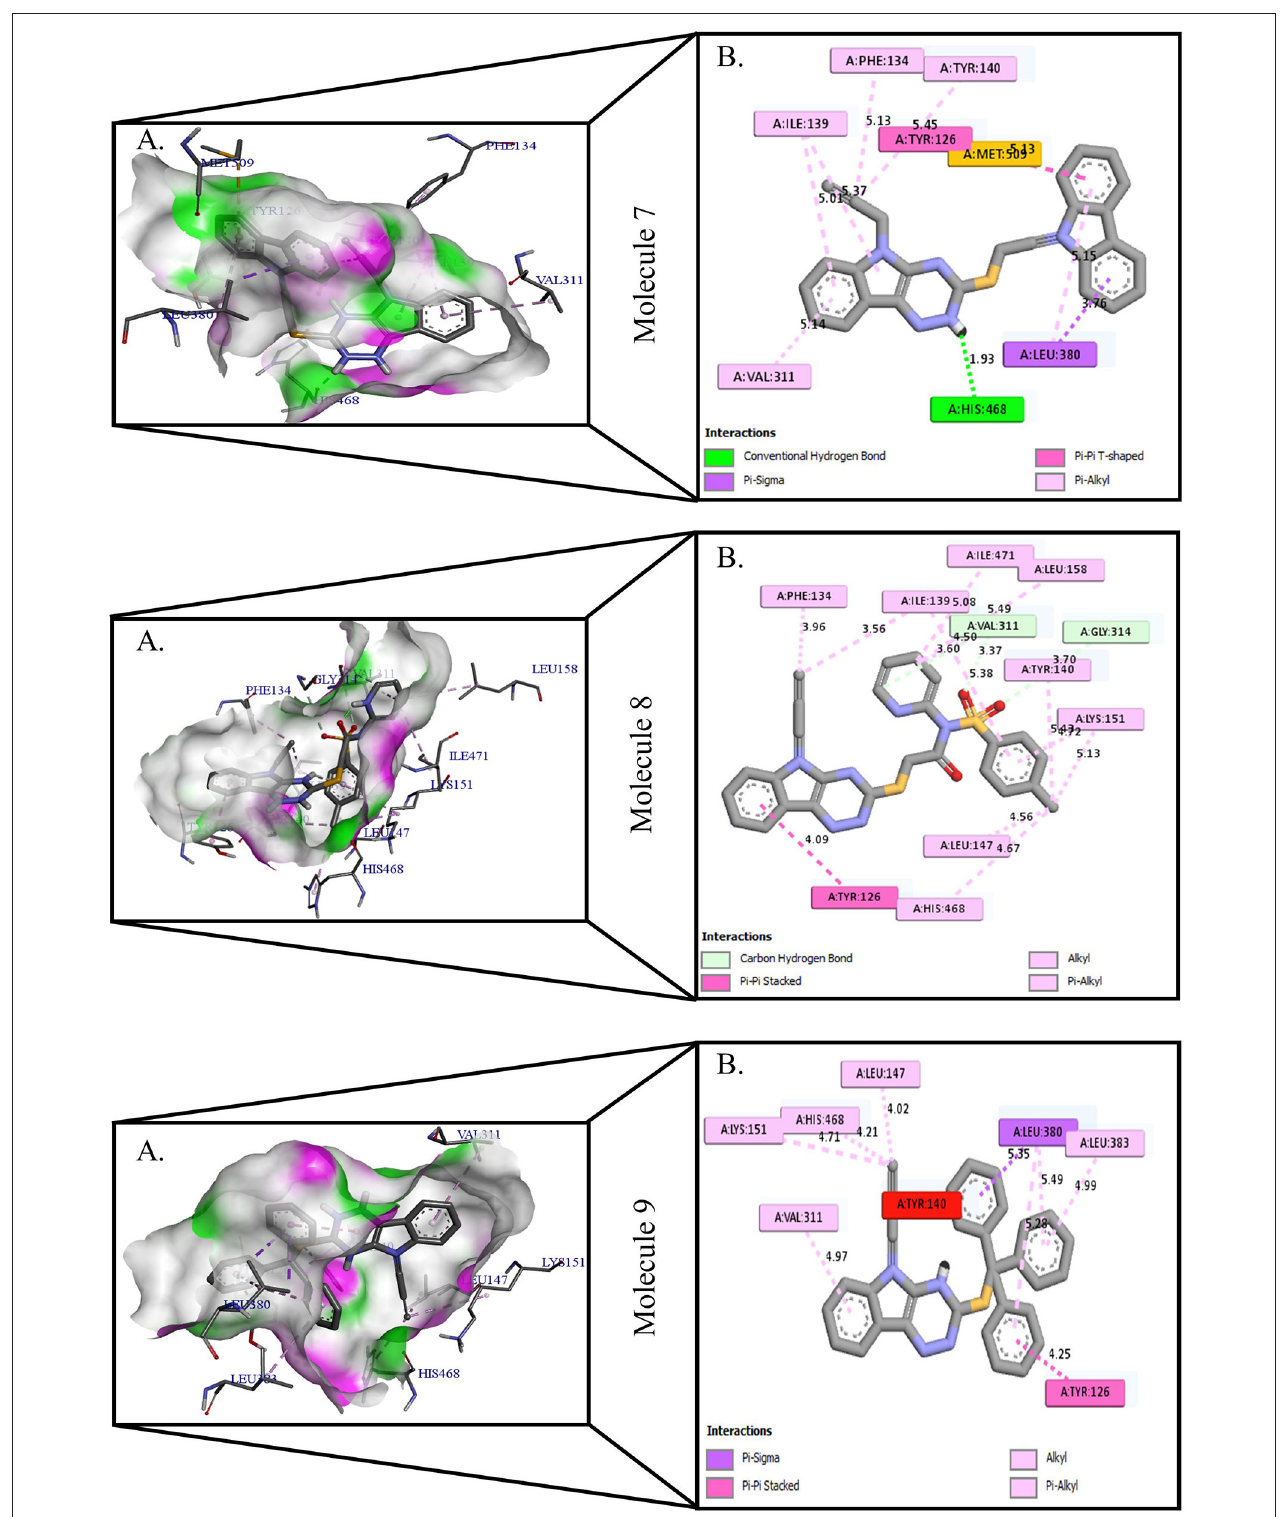
FIGURE 3 | Protein-ligand presentation of CYP51 with molecules 7, 8, and 9. (A) 3D receptor-ligand presentation, and (B) 2D receptor-ligand interactions.